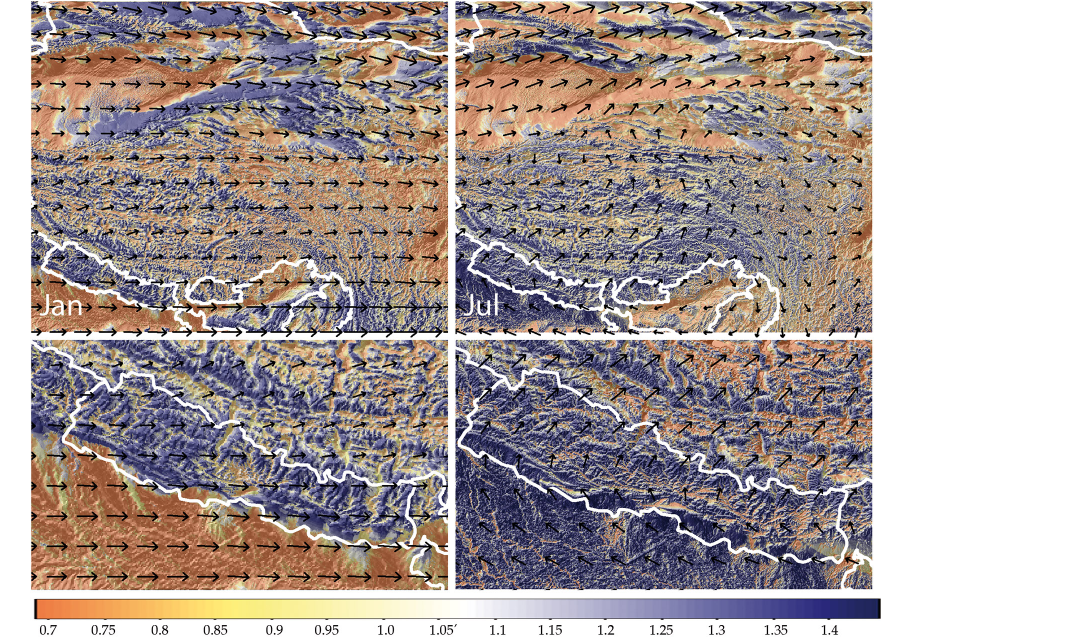
Figure 3. The spatial distribution of the wind-effect parameter for January and July 2010. The arrows represent the 500hPa ERA-Interim wind field.